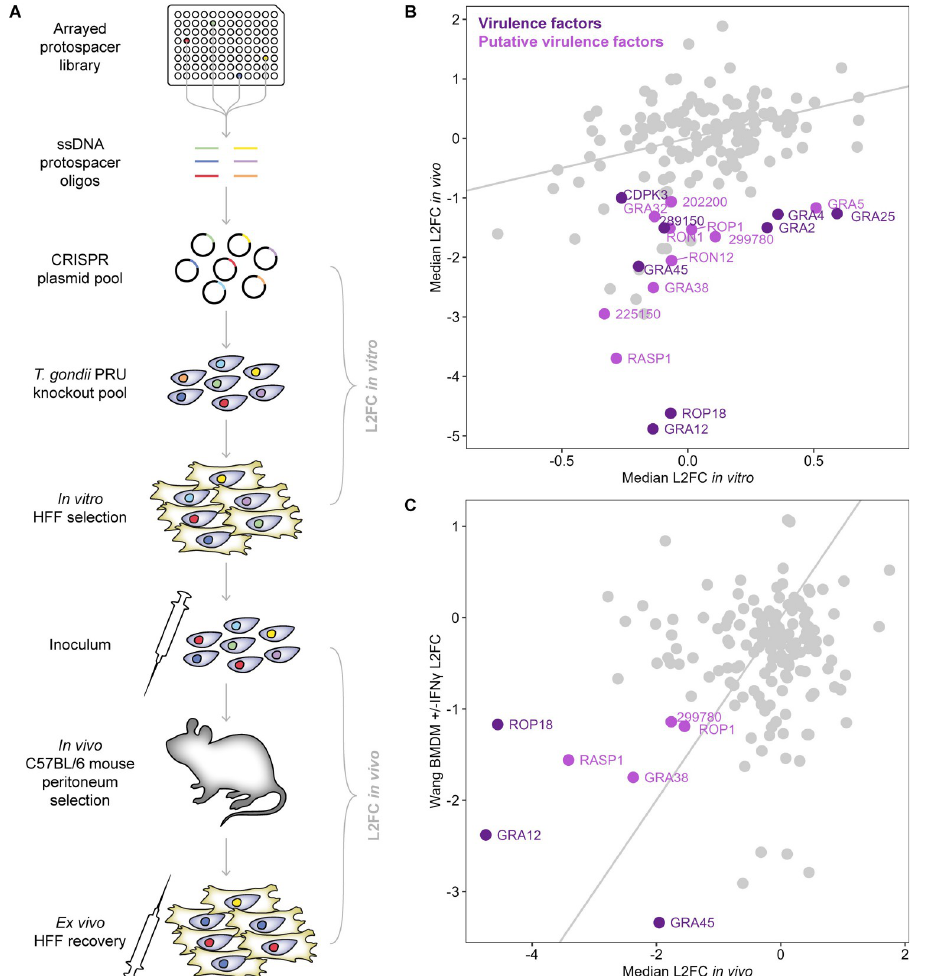
Fig 1. Targeted in vivo CRISPR-Cas9 knockout screening of T . gondii rhoptry and dense granule proteins. A. Schematic of knockout screen workflow. Protospacers encoded on arrayed ssDNA oligonucleotides are assembled by pooled Gibson cloning into a Cas9-sgRNA vector. The resulting plasmid pool is transfected into T . gondii PRU and the parasites selected in vitro in HFFs for integration for six days. Surviving parasites are used to infect five mice by intraperitoneal injection, recovered after five days and expanded for one further lytic cycle in vitro . The sgRNA cassettes are amplified from plasmid or parasite genomic DNA and sequenced to determine the relative abundance of each guide. B. Scatter plot of median L2FCs for each gene in vitro and in vivo . Putative virulence factors are identified as genes with an in vivo L2FC � -1 and HFF z-score [18,19] � -1 (S1F Fig) . The grey line indicates equal L2FCs. C. Correlation between median L2FCs in vivo from this study and L2FCs between IFN γ -stimulated versus unstimulated BMDMs from [19]. Genes with a L2FC � -1 in both screens are labelled. The grey line indicates equal L2FCs.